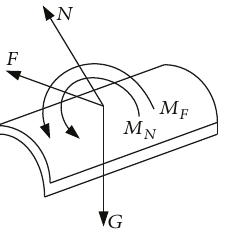
Figure 3: The forces of the adapter.